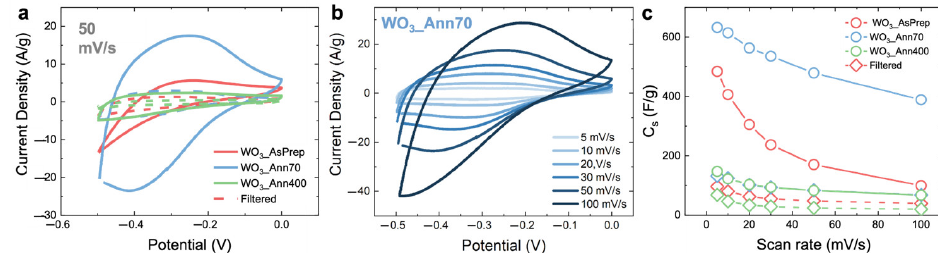
Figure 3. ( a ) CV curves obtained at 50 mV/s of NF (solid lines) and F (dotted lines) WO 3 _AsPrep, WO 3 _Ann70 and WO 3 _Ann400 pastes electrodes; ( b ) CV curves of WO 3 _Ann70 electrode obtained at different scan rate; ( c ) C s as a function of scan rate obtained from CV curves of NF (solid lines) and F (dotted lines) WO 3 _AsPrep, WO 3 _Ann70 and WO 3 _Ann400 pastes electrodes. The potential is measured versus SCE.